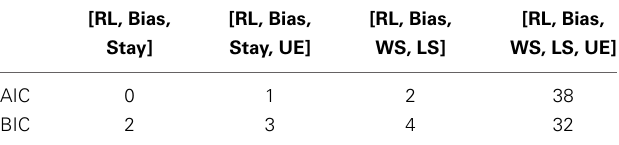
Table 1 | Results of model comparison.